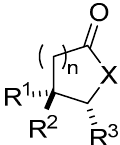
Table 1. Designed Hib-ester analog compounds: structural modification explored in the present work and the respective IC 50 value per compounds at 24 h, determined by MTT assay in RPMI 8226 cells at different concentrations (10, 100 and 500 µM); n.e. * = compounds not effective at 500